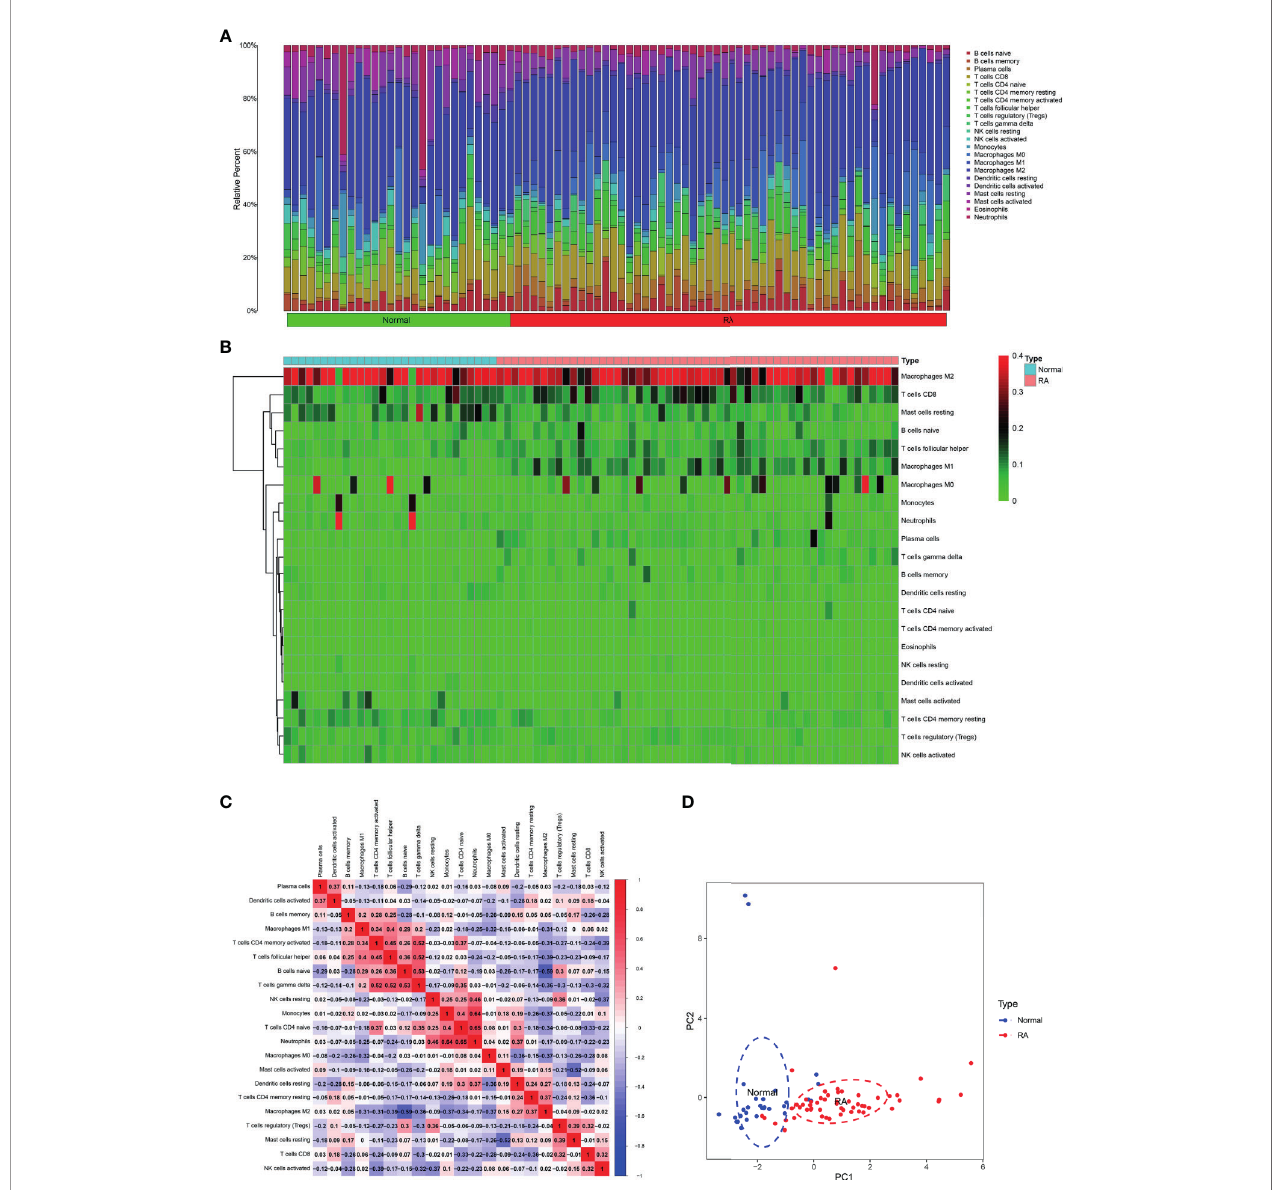
FIGURE 2 | Immune cell in fi ltration in RA and normal synovial tissues. The composition of 22 kinds of immune cells in each sample was showed in a histogram (A) and a heatmap (B) . (C) The correlation of 22 types of immune cells in RA synovial tissues was evaluated. Red: positive correlation; blue: negative correlation. (D) PCA analysis was performed to classify in fi ltrating immune cells between RA and normal synovial